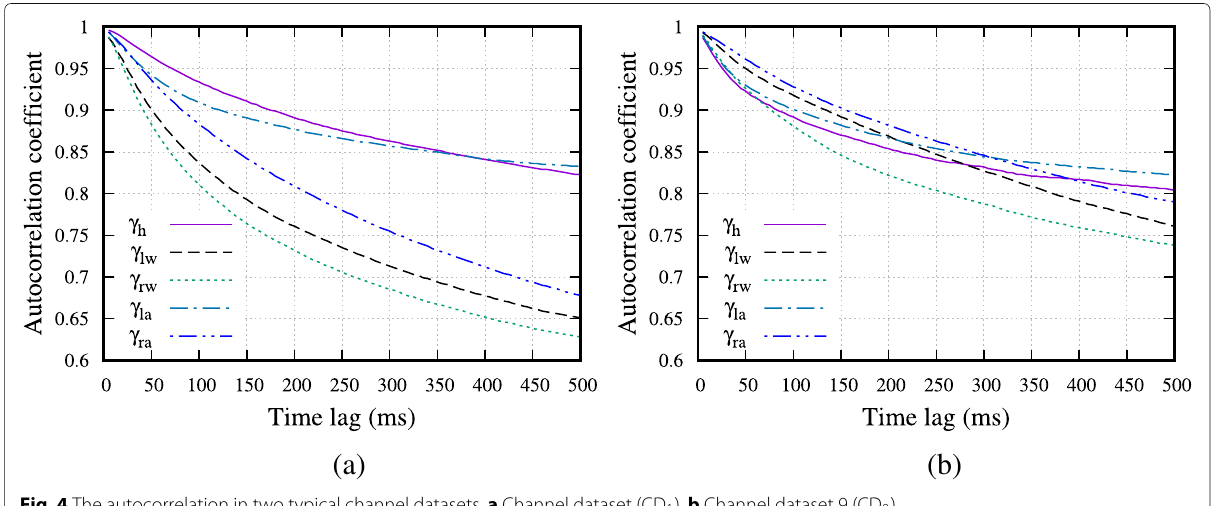
Fig. 4 The autocorrelation in two typical channel datasets. a Channel dataset (CD 1 ). b Channel dataset 9 (CD 9 )